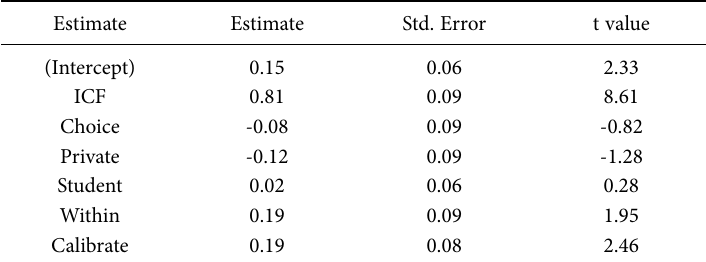
Table 4. Regression results: marginal distribution type